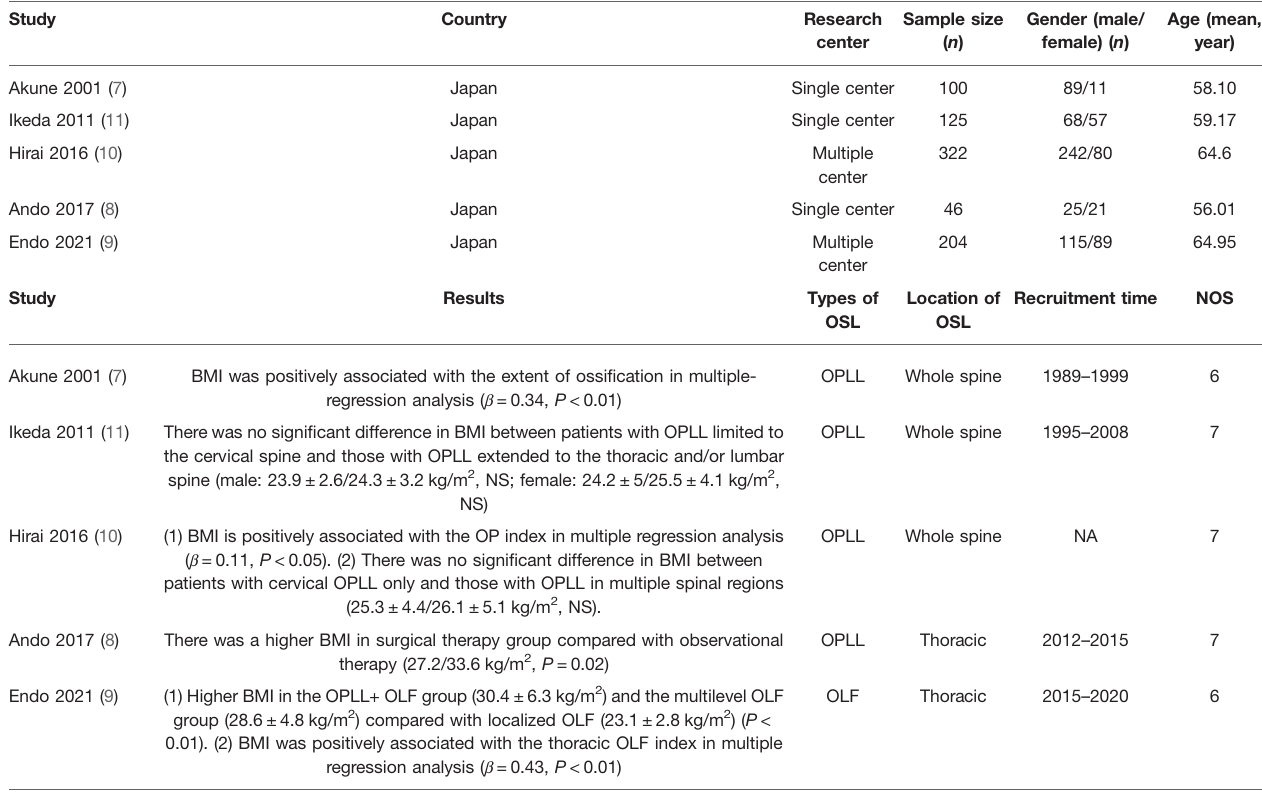
TABLE 2 | Characteristics of included studies about the relationship of BMI with the severity of OSL. Study